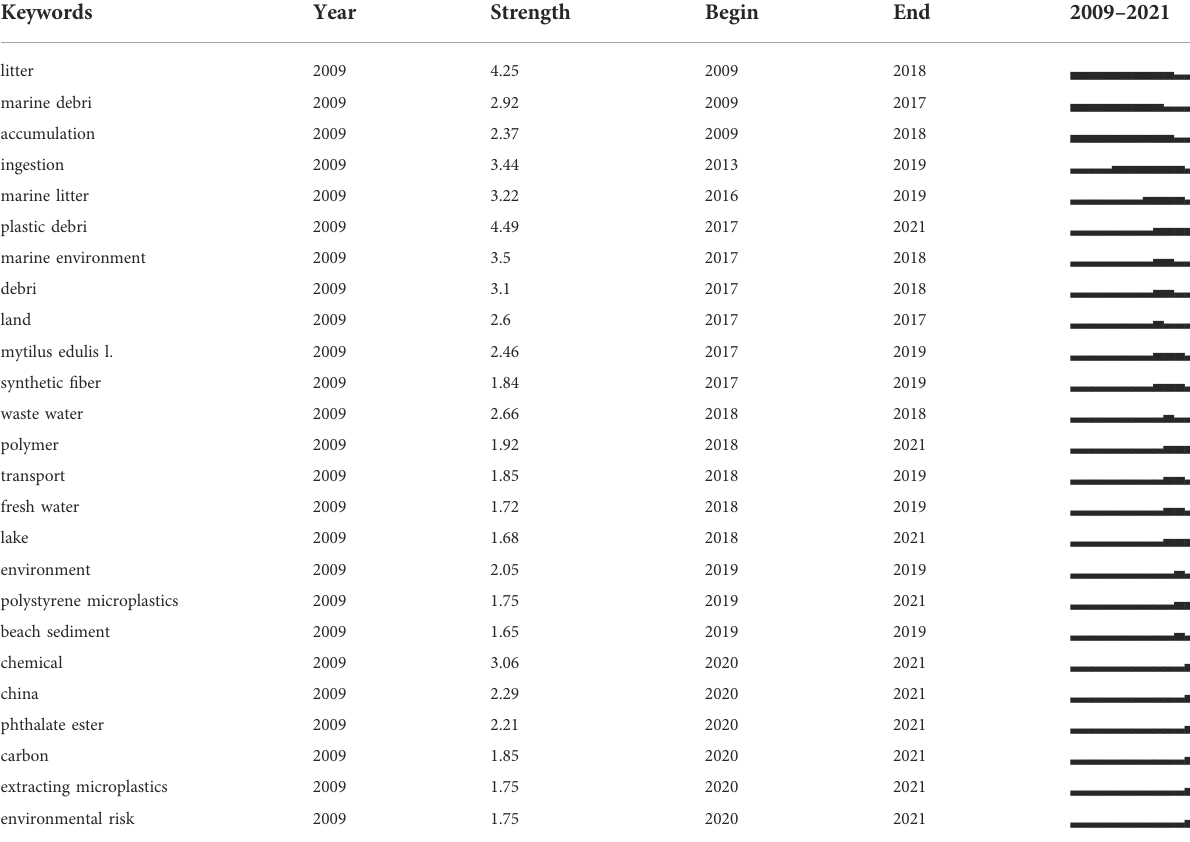
TABLE 5 Top 25 keywords with the strongest citation